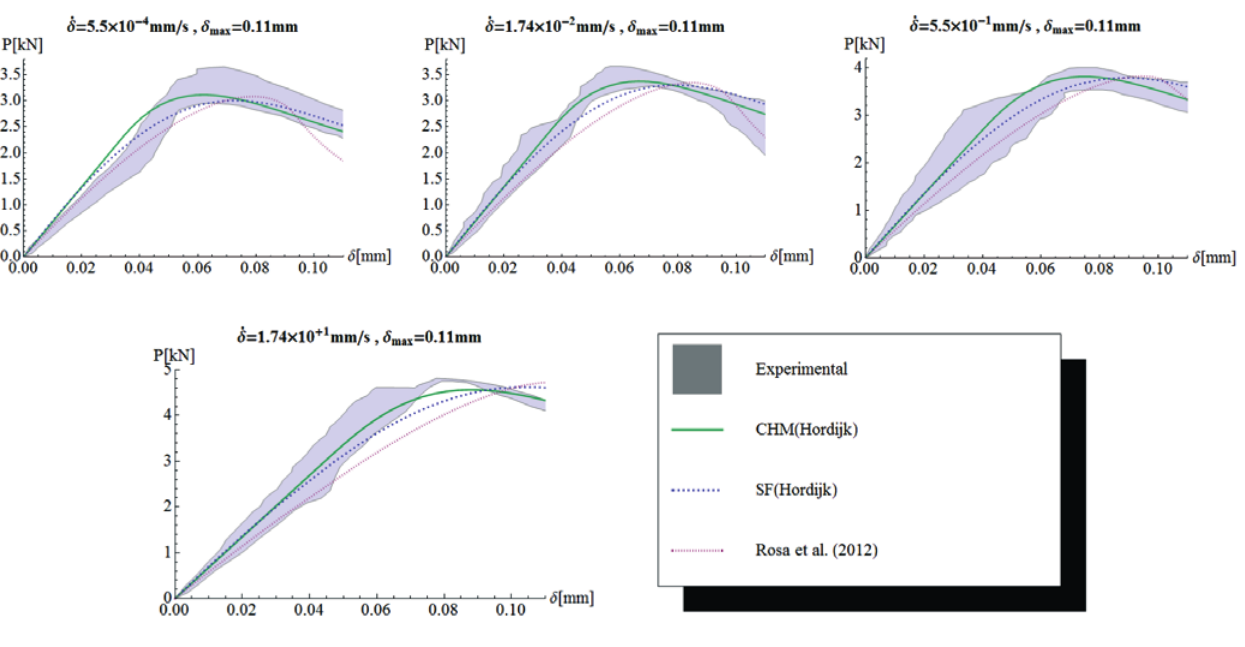
curve for the range of 0 to 0.11 mm using Hordijk (1991) [33] curve set in section 5.3P-